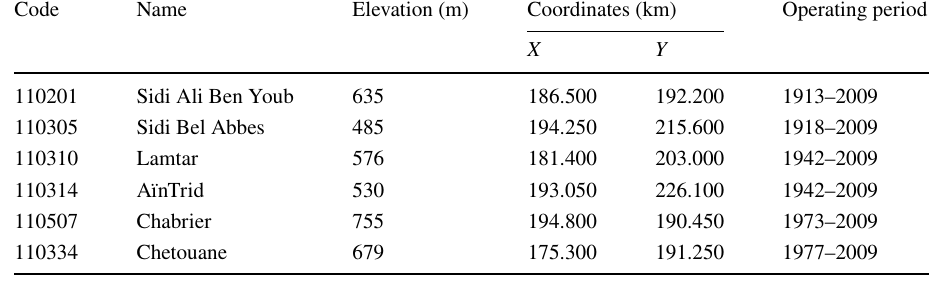
Fig. 2 Record of missing data by station and year